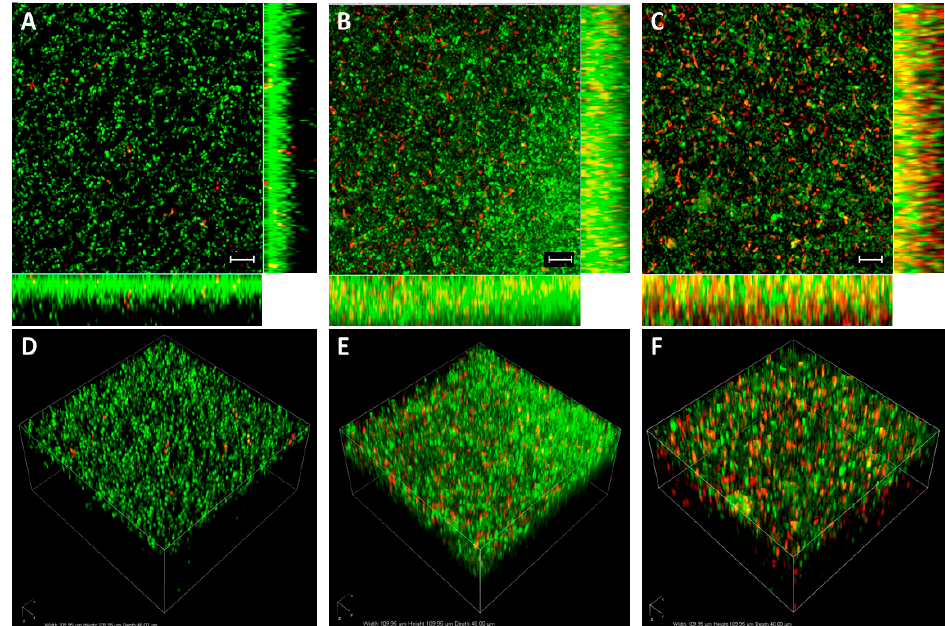
Figure 2. CLSM of BC- Lf at different incubation times in AgNPs solution. Samples were stained with SYTO9/PI dyes. The images are maximum intensity projections of 20 μ m in-depth of ( A ) BC after Lf adsorption (BC- Lf ), ( B ) BC- Lf after 15 min of incubation in AgNPs (AgNP-BC- Lf ), and ( C ) BC- Lf after 30 min of incubation in AgNPs. Scale bars = 10 µ m. ( D – F) images are three-dimensional reconstructions of ( A – C ),